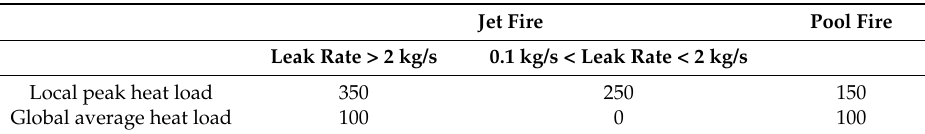
Table 1. The heat fluxes are incident heat fluxes. Table 1. Proposed incident heat fluxes in kW/m 2 based on